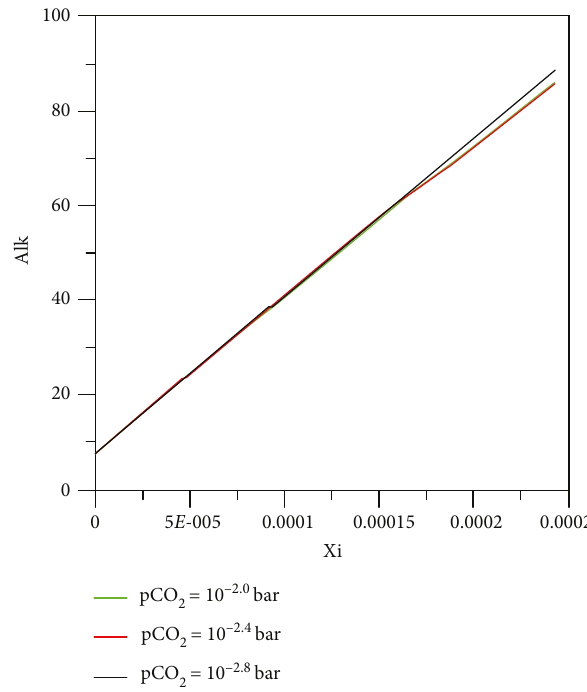
Figure 4: Plot of alkalinity vs. the reaction progress variable showing the results of reaction path modeling for the dissolution of granulite under di ff erent fCO values (see 2